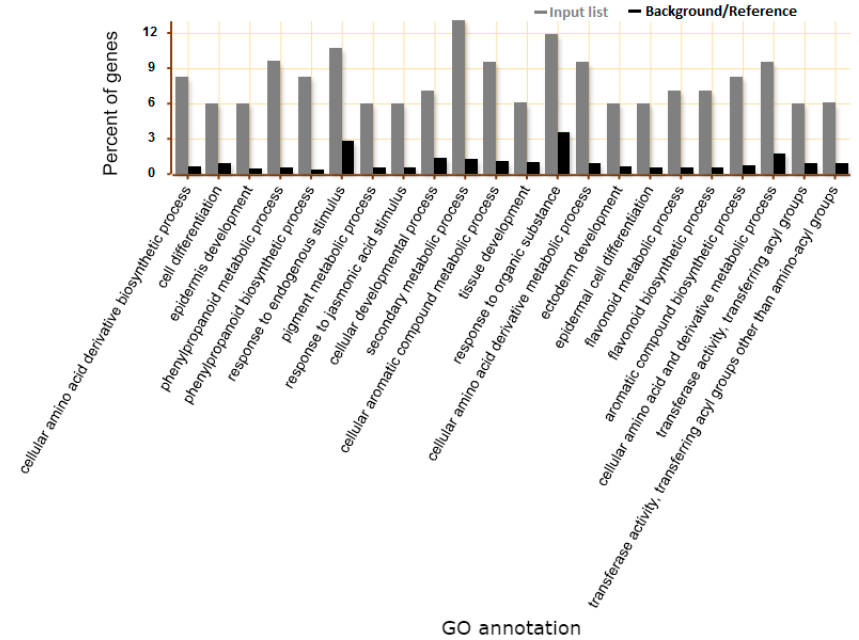
Figure 6. Detailed information of biological process representing the percent of genes involved in biological process pathways of 89 genes of interest induced by imazethapyr (IM) in wild type (WT) and downregulated in ros1 mutant, performed by using singular enrichment analysis (SEA) in AgriGo. Gray and black bars indicate the percent of genes related to the input list and the percent of genes compared to genome reference, respectively.